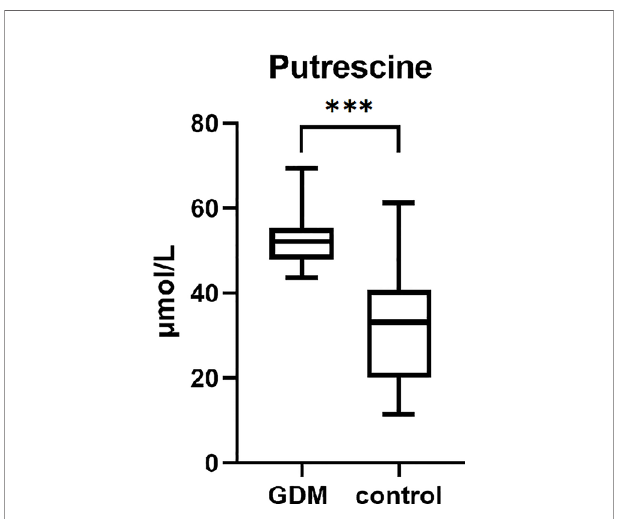
FIGURE 1 | The serum putrescien in the fi rst trimester of women with GDM and controls. (***P < 0.001).